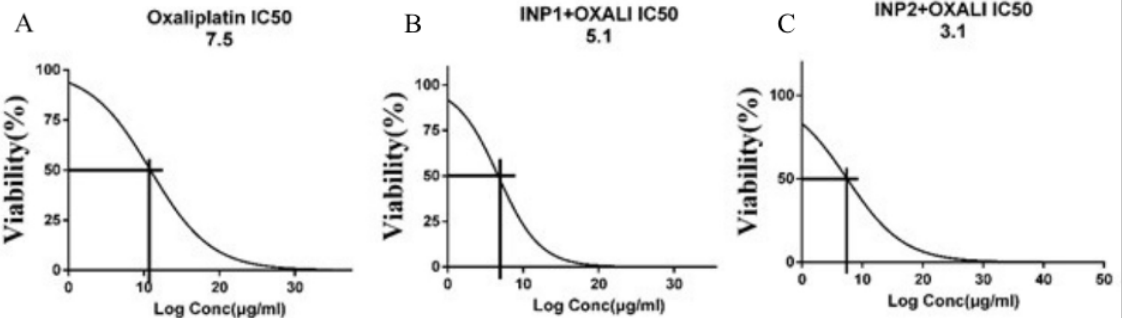
Figure 6. Inhibition effect of Oxaliplatin and INP1 + OXALI IC50 on HT-29 cells growth. IC50 was calculated for 3 formulations by MTT assay: ( A ) Oxaliplatin, ( B ) INP1 + OXALI, and ( C ) INP2 + OXALI. Abbreviations: INP1, iodine nanoparticle 1. INP2, iodine nanoparticle 2. OXALI, Oxali- platin.